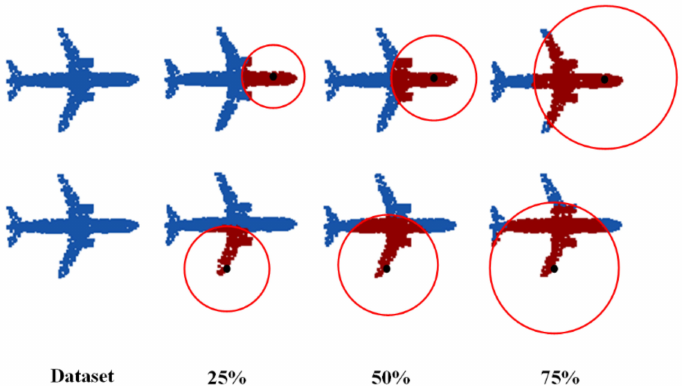
Figure 1. The process of generating incomplete point cloud data, where the random center point is at the center of the